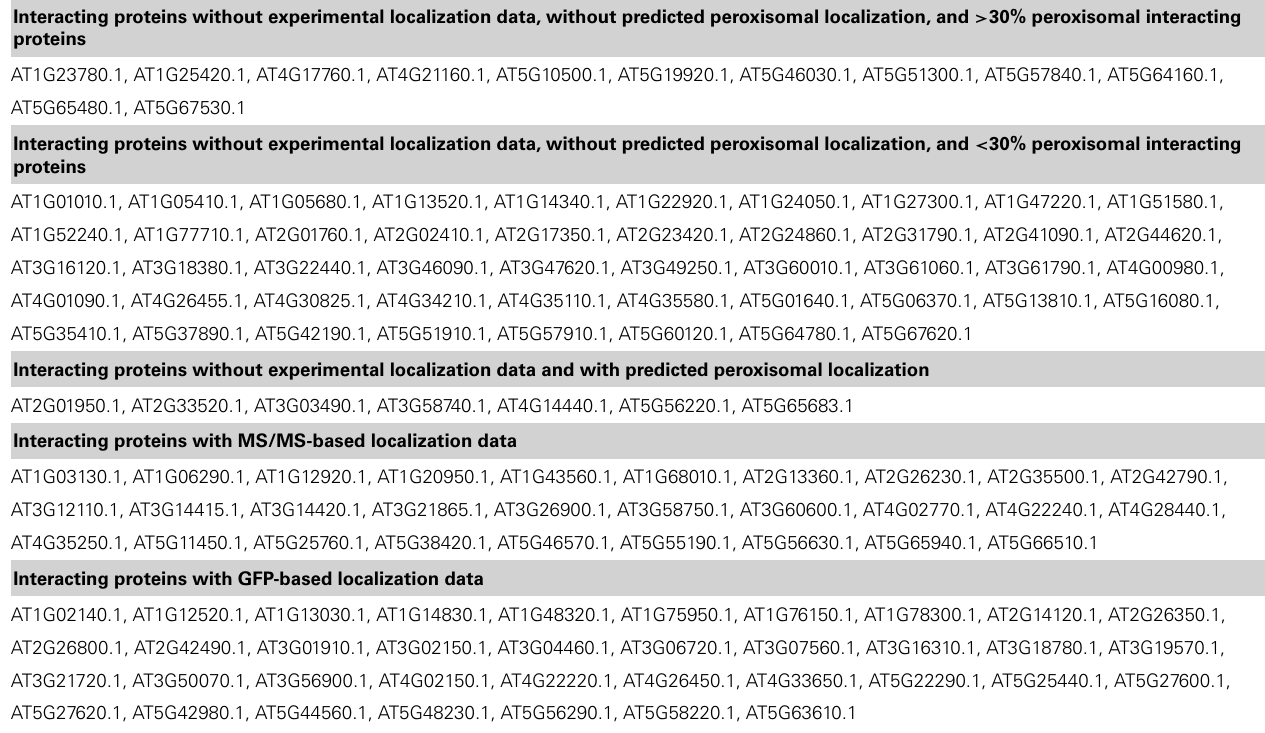
Table 1 | SUBA3 localization data of proteins interacting with confirmed peroxisomal proteins according to Kaur and Hu (2011). Interacting proteins without experimental localization data, without predicted peroxisomal localization, and > 30% peroxisomal interacting proteins AT1G23780.1, AT1G25420.1, AT4G17760.1, AT4G21160.1, AT5G10500.1, AT5G19920.1, AT5G46030.1, AT5G51300.1, AT5G57840.1,